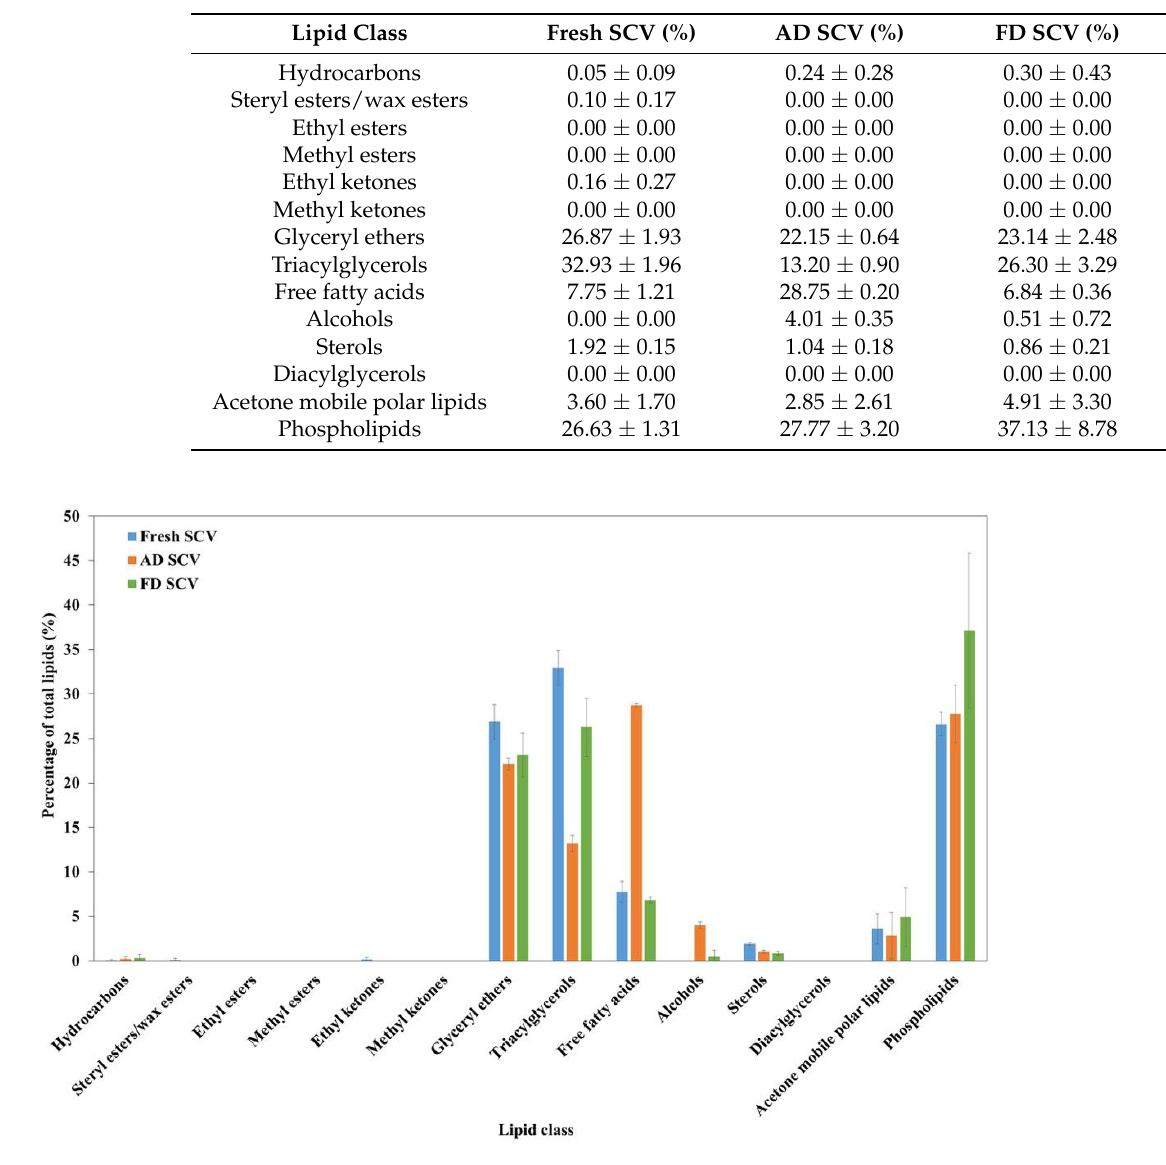
Table 2. Total lipid class of fresh, air-dried (AD SCV), and freeze-dried (FD SCV) sea cucumber viscera.